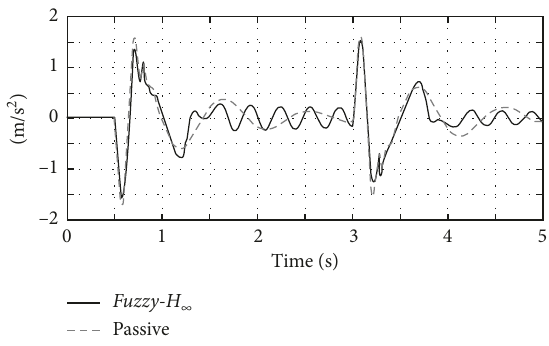
Figure 16: Pitch angle